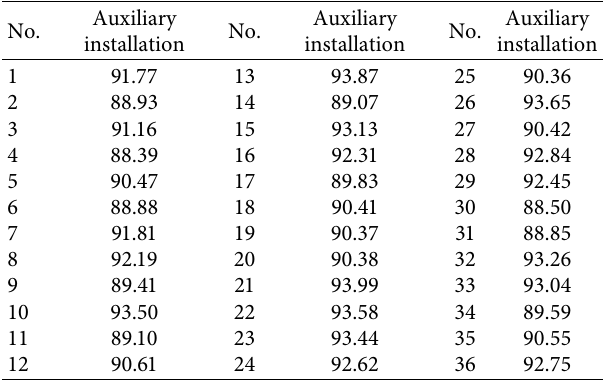
Table 7: Auxiliary installation